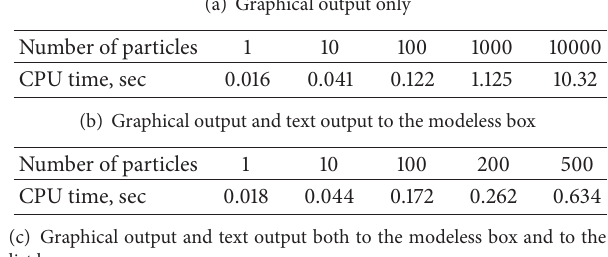
Table 1: The elapsed CPU time required for simulating the motion of an ensemble of particles in the thread function ThreadProc (no sleep